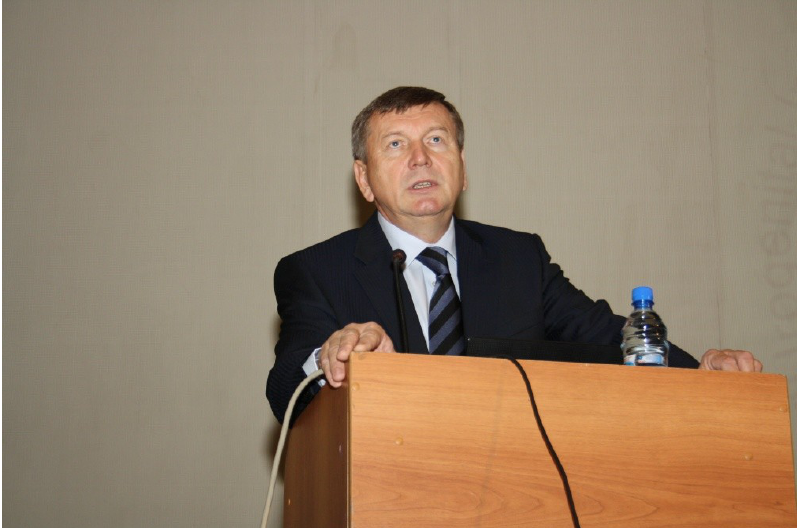
Figure1. Minister of Public Health of the Novosibirsk region, Professor Leonid